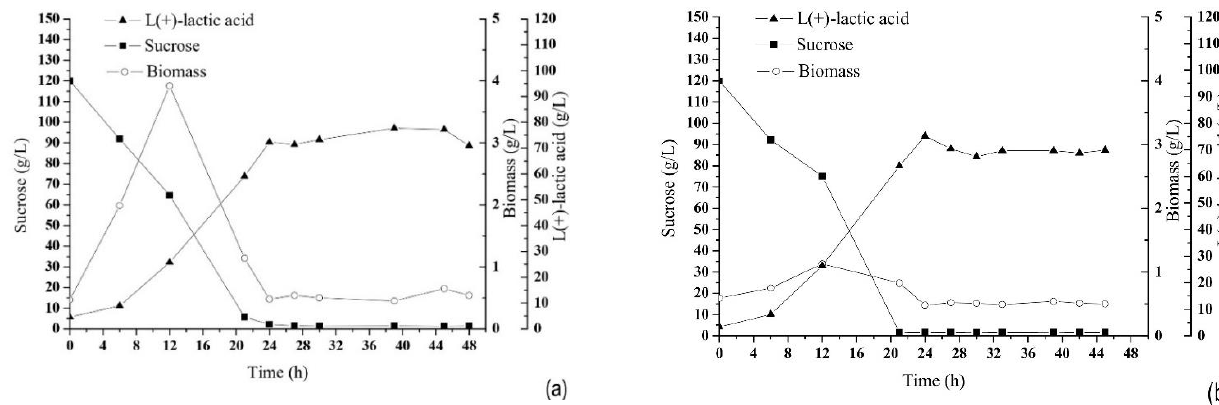
Figure 5. Kinetics of lactic acid production, sucrose consumption and growth of microorganism in 0.5-L batch reactor using NaOH 10 N to control pH, ( a ) initial sucrose concentration of 120 g/L in absence of salts from MRS medium and ( b ) presence of salts from MRS medium.